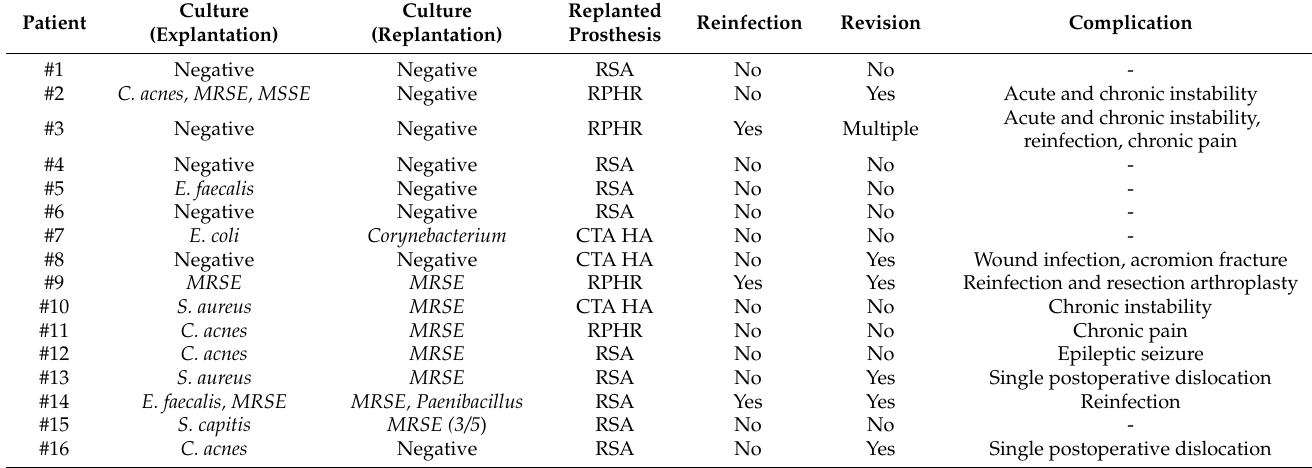
Table 3. Overview of the included patients with microbial spectrum, replanted prosthesis model and revision, as well as surgical and general complications. C. acnes : Cutibacterium acnes , MRSE : Methicillin-resistant Staphylococcus epidermidis , MSSE : Methicillin-sensitive Staphylococcus epidermidis , E. facalis : Enterococcus faecalis , E. coli : Escherichia coli , S. aureus : Staphylococcus aureus , S. capitis : Staphylococcus capitis , RSA: reverse shoulder arthroplasty, CTA HA: large-head hemiarthroplasty, RPHR: reverse proximal humerus replacement.